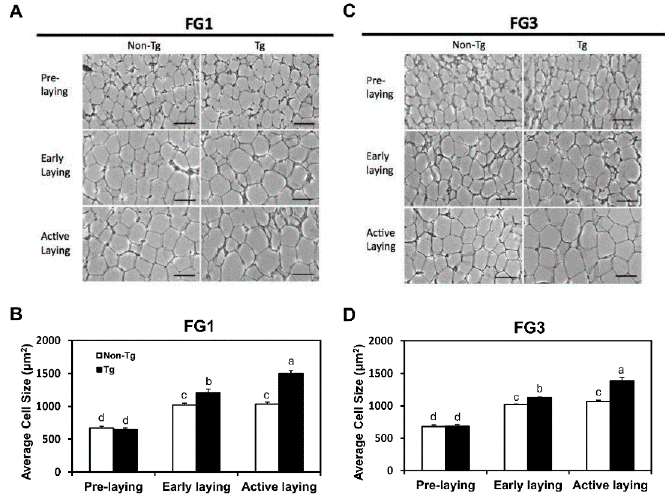
Figure 2. Adipocyte size continually increases G0S2 transgenic quail, but stays constant in non-transgenic quail during laying. Histological images of adipocytes at different stages of egg laying for ( A ) line FG1 and ( C ) line FG3. Scale bar = 50 μ m. Average cell size was calculated for ( B ) line FG1 and ( D ) line FG3 ( n = 5 per group per time point). Bars represent mean ± SEM. Bars that share the same superscript letter are not significantly different from each other ( p < 0.05).